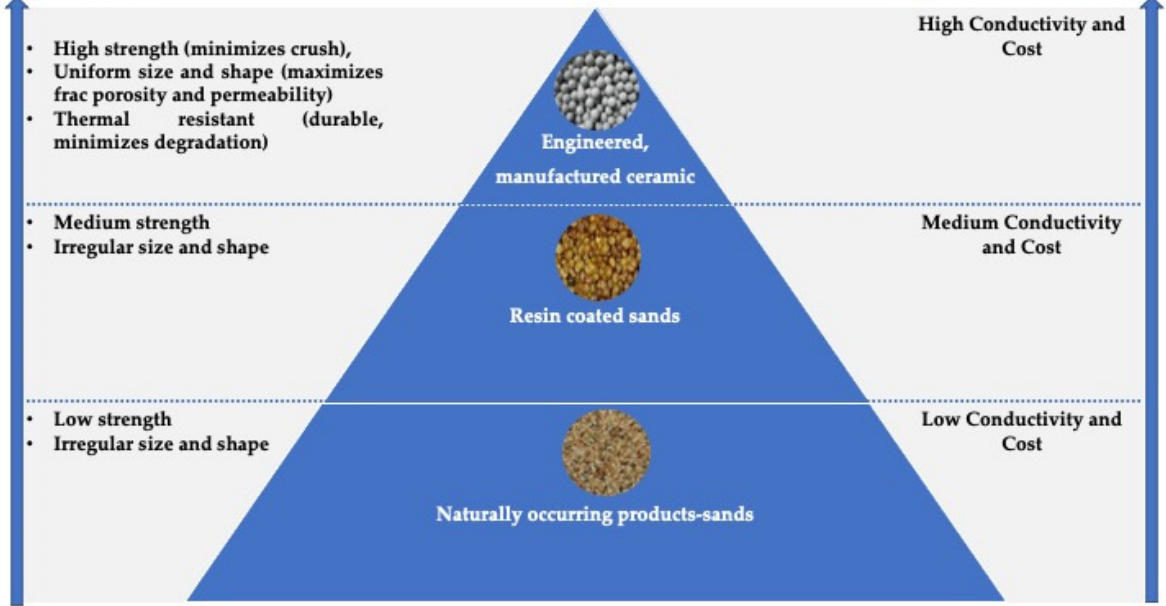
Figure 20. Proppants and their features (modified from [212]).